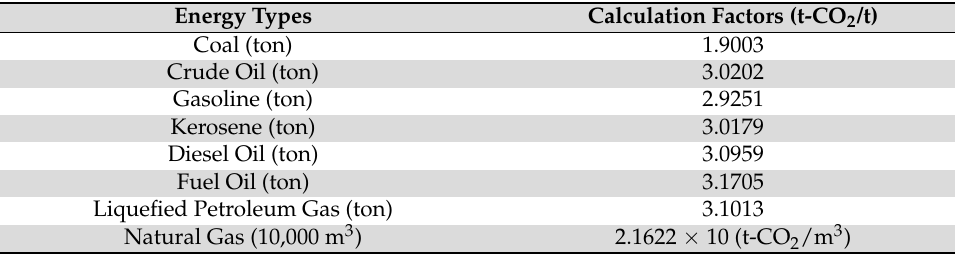
Table 8. Factors in the calculation of direct CO 2 emissions from each energy type